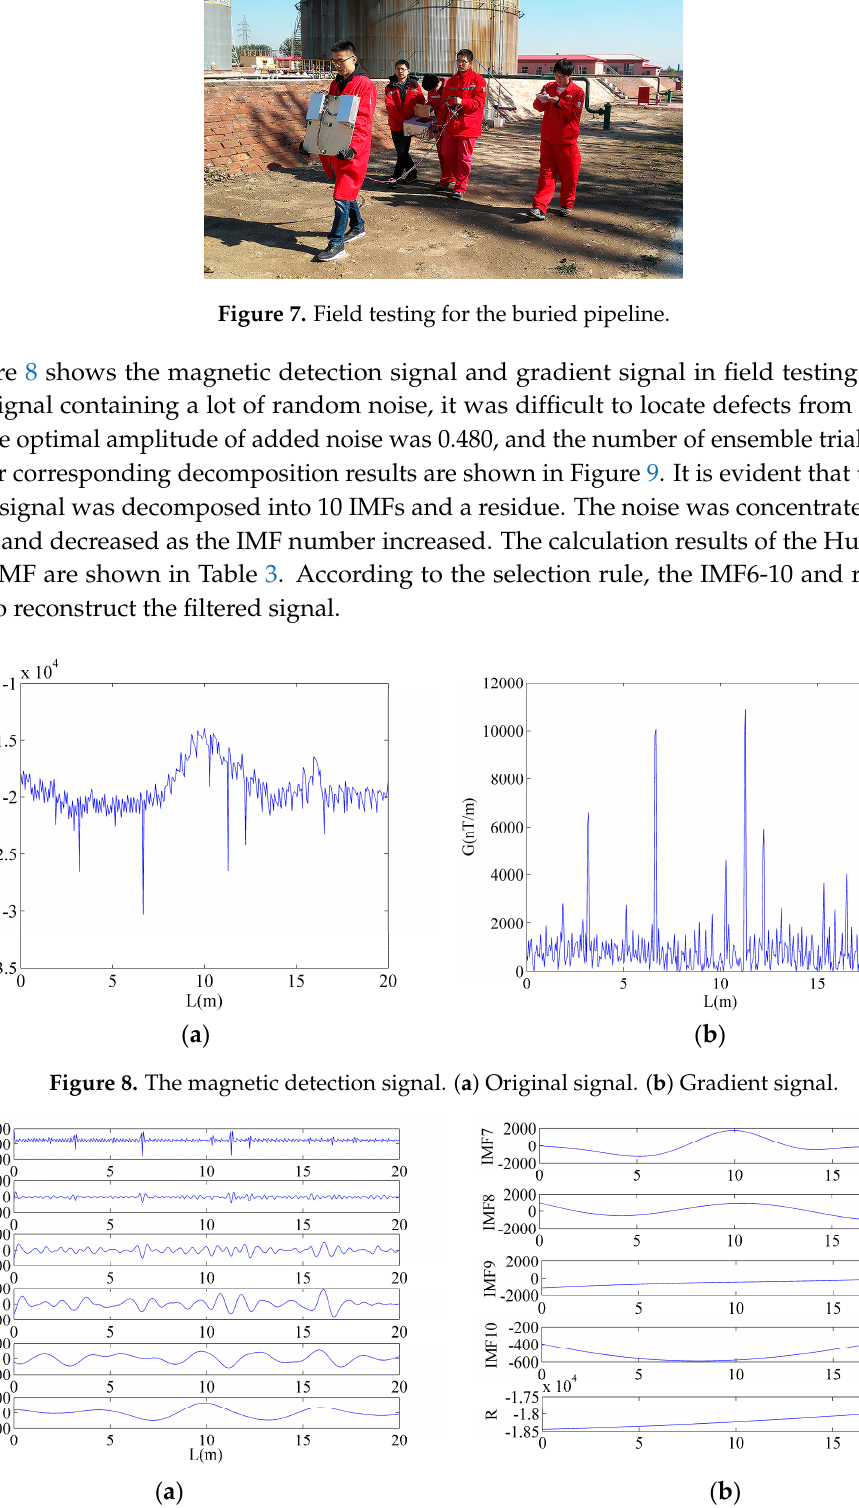
Figure 9. Decomposition results of the magnetic detection signal via optimal CEEMDAN. ( a ) IMF1– IMF6 results. ( b ) IMF7–IM10 and residue results. Table 3. Calculation results of the Hurst exponent.